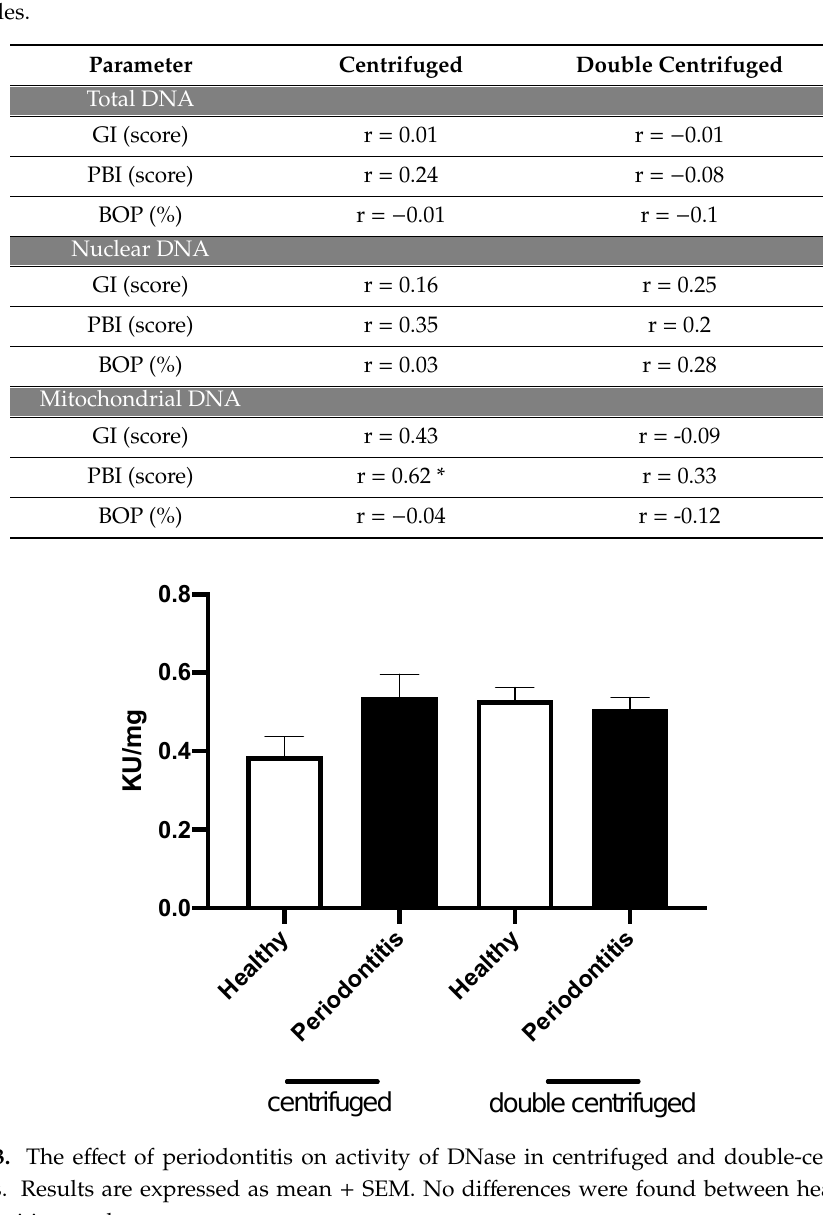
Table 2. Correlation between oral health indexes and total, nuclear DNA (ncDNA), and mitochondrial DNA (mtDNA) in whole saliva, centrifuged (1600× g ) and double-centrifuged (1600× g + 16,000× g ) samples.